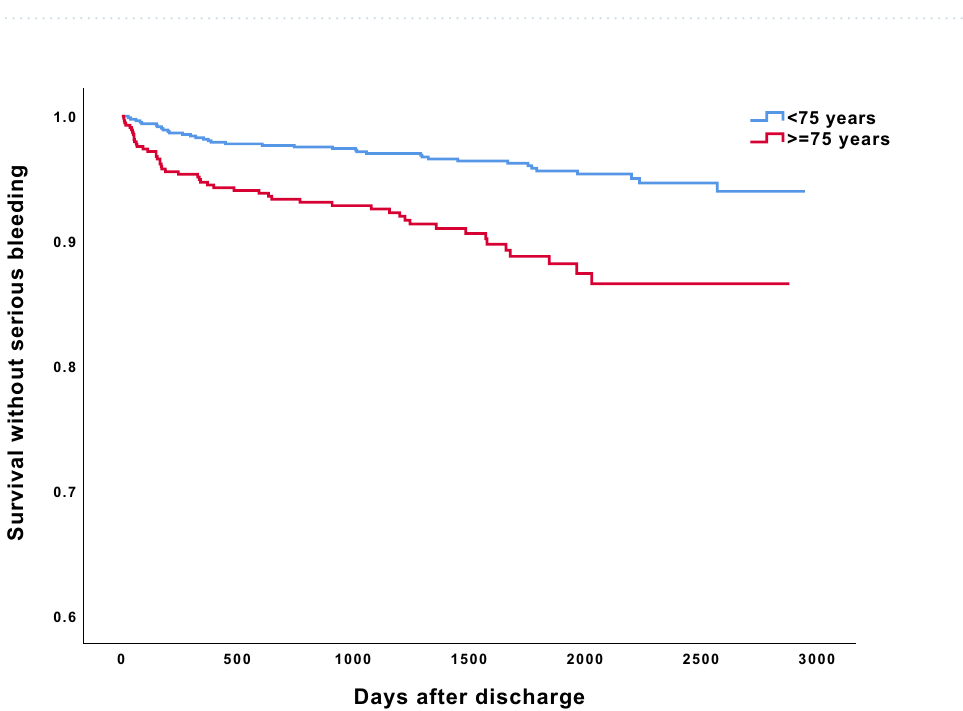
event (STEMI/NSTEMI/UA), invasive revascularization, or pharmacologic treatment at discharge. Analyses of interactions between all variables using competing risk analysis gave the same significant results as the multi- variable Cox analysis.